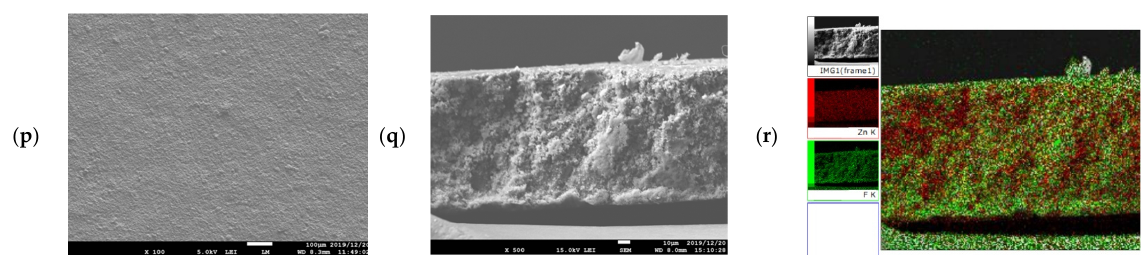
Figure A8. SEM images of surface and cross-section membranes using ZIF-8 and [EMIM][Tf 2 N]@ZIF-8 composites, accompanied by EDS mapping for [EMIM][Tf 2 N]@ZIF-8 MMMs: ( a , b ) PSf; ( c , d ) 10 wt.% ZIF-8(PSf); ( e – g ) 10wt.%[EMIM][Tf 2 N]@ZIF-8(low) (PSf); ( h – j ) 10wt.%[EMIM][Tf 2 N]@ZIF-8(high) (PSf); ( k , l ) 30 wt.% ZIF-8(PSf); ( m – o ) 30 wt.%[EMIM][Tf 2 N]@ZIF-8(low) (PSf); and ( p – r ) 30wt.%[EMIM][Tf 2 N]@ZIF-8(high) (PSf).